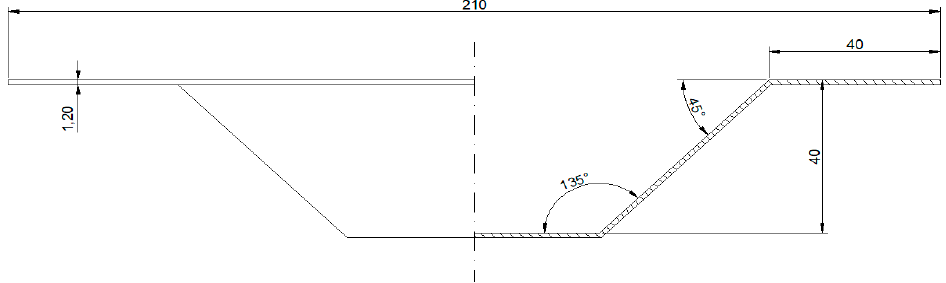
Figure 2. Dimensions of the mold used in the tests (unit: mm).